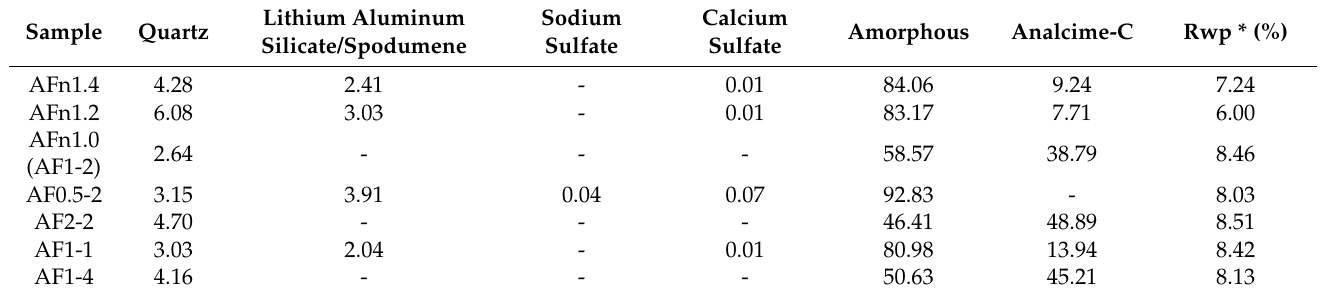
Table 3. Rietveld quantitative analysis results of AFs